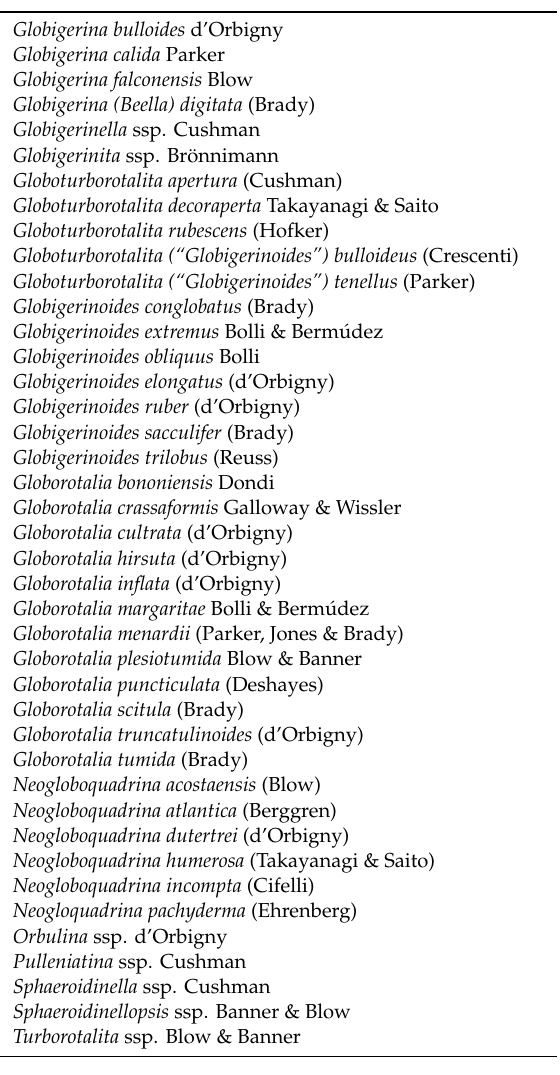
Table 1. Taxonomic appendix with the formal names of the planktonic foraminifera appearing throughout the